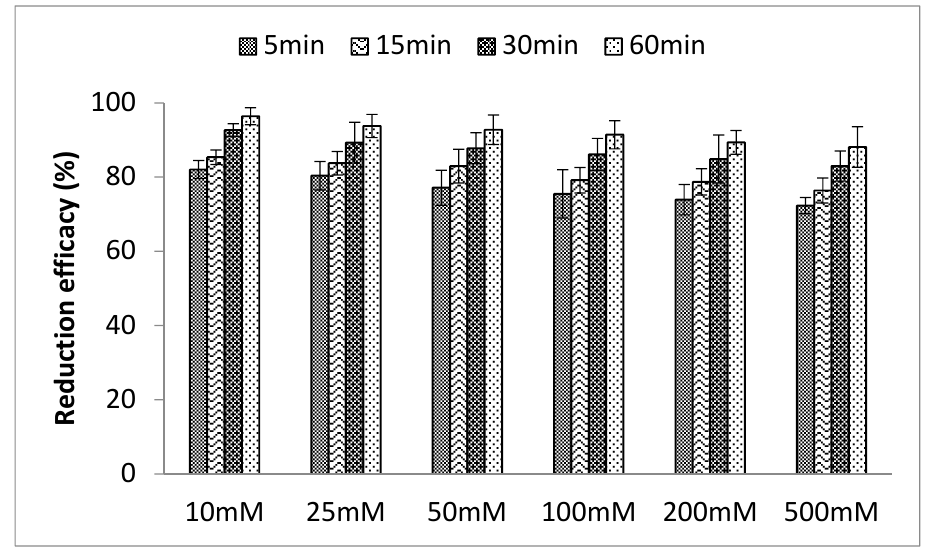
Figure 4. Effects of ionic strength: [Cr(VI)] 0 = 10 mg·L − 1 , Cr(VI) volume = 25 mL, contact time = 60 min, pH = 2, PLE quantity = 1.5 mL, ionic strength = 10–500 mM.